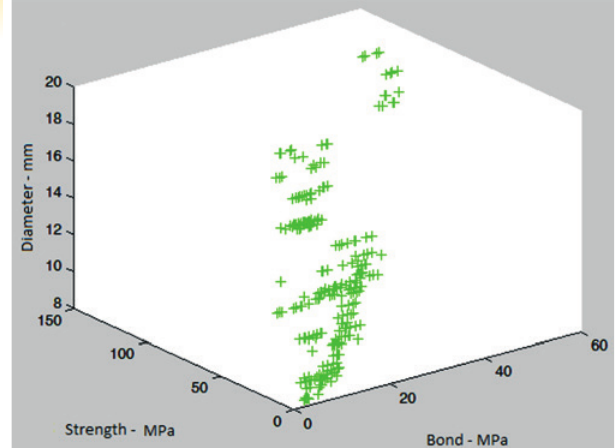
Figure 4 Distribution of bond tests data pull-out, used to compose